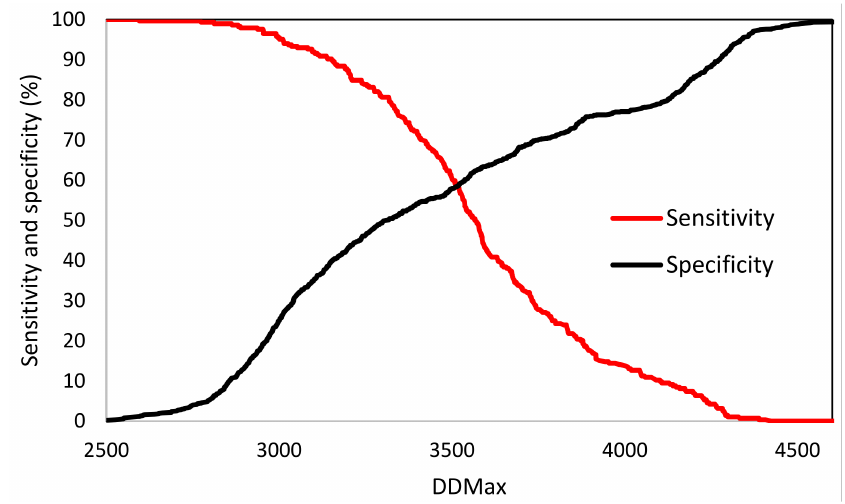
Figure 12. Variation in specificity and sensitivity of detection of Ixodes scapularis for different val- ues of the maximum cumulative annual surface degree-days above 0 ◦ C within forest covered areas